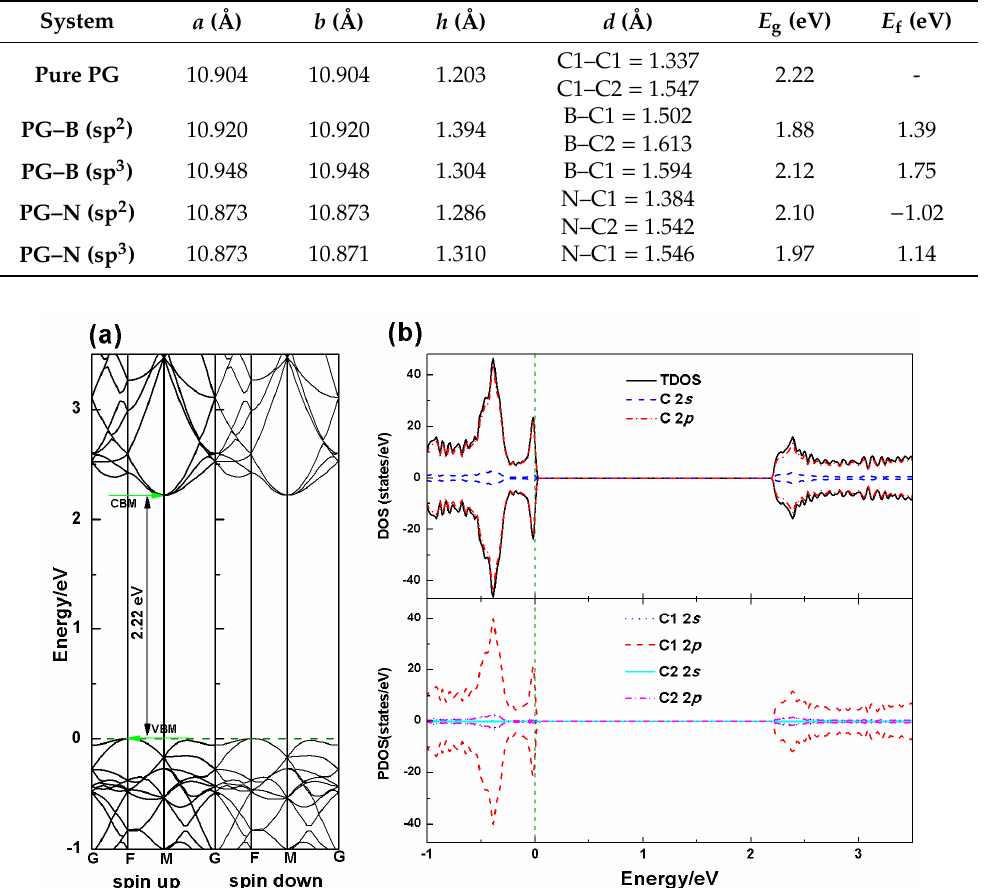
Figure 2. Calculated electronic energy band structure ( a ), total density of states (TDOS) and partial density of states (PDOS) of the pure PG ( b ). On the top layer of ( b ), the black solid line in the density of states (DOS) plot shows the TDOS of the system, and the blue dash and the red dash dot lines indicate the PDOS of the 2s and 2p states of carbon atoms, respectively. On the bottom layer of ( b ), the blue dot and the red dash lines indicate the PDOS of 2s and 2p states of C1 atoms, respectively, and the cyan solid and the magenta dash dot lines indicate the 2s and 2p states of C2 atoms, respectively. The olive dash lines represent the Fermi energy level. Valence band maximum (VBM) and conduction band minimum (CBM) indicate the valence band maximum and the conductance band minimum, respectively.